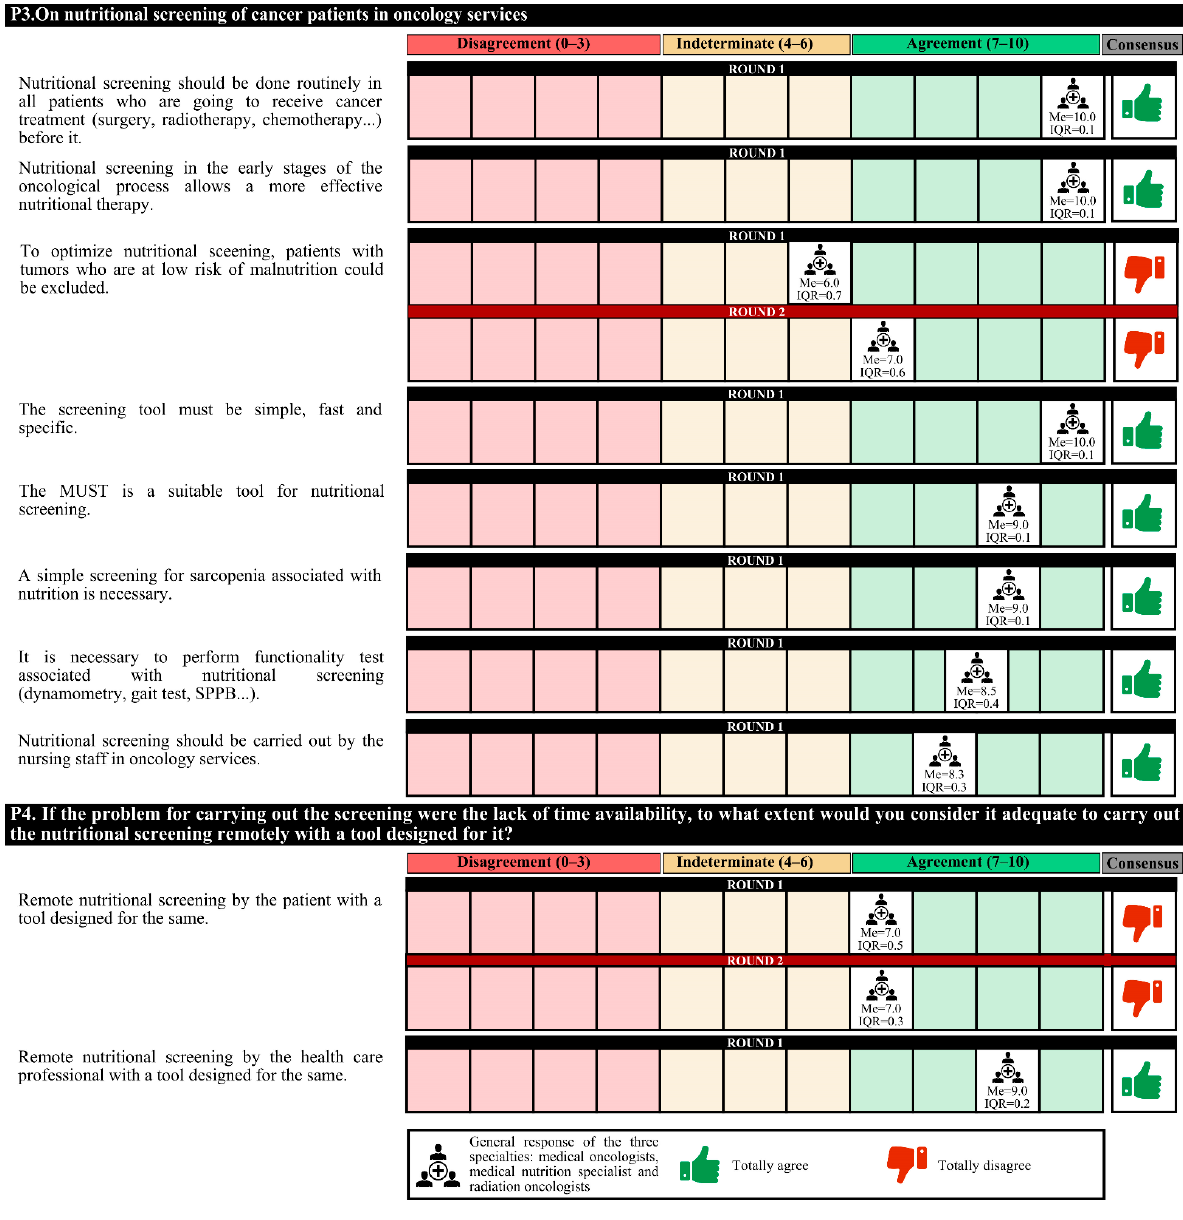
Figure 2. Answers about nutritional screening (I). IQR, interquartile range; MUST, Malnutrition Universal Screening Tool; Me, median; SPPB, short physical performance battery.